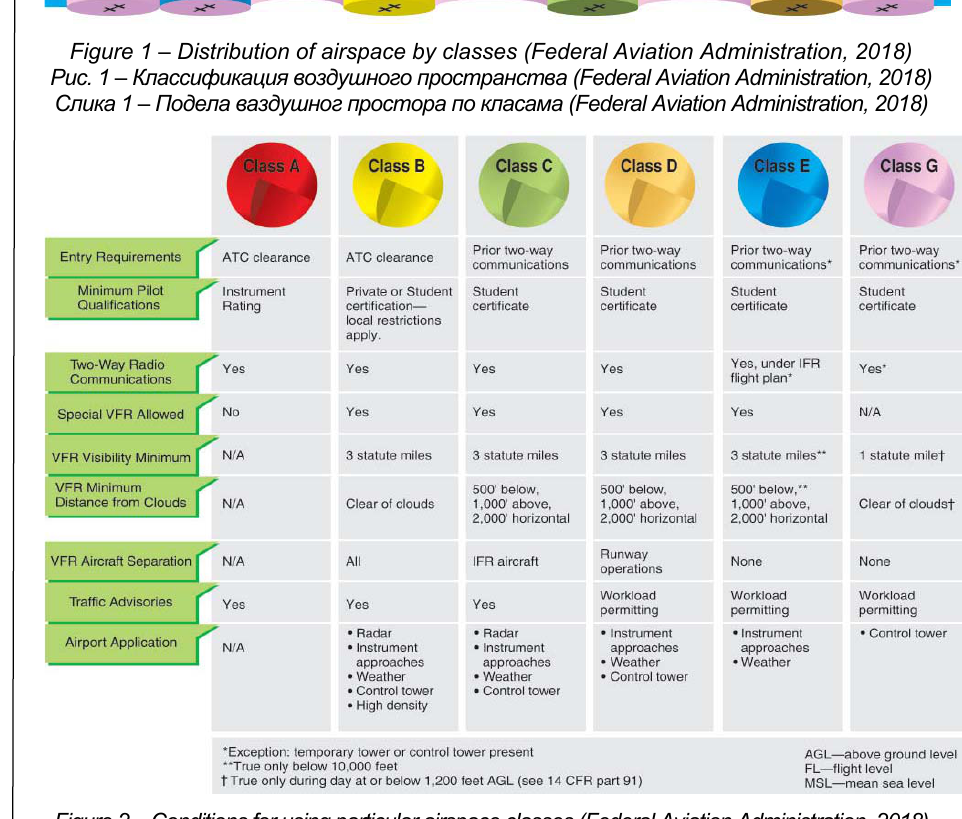
Figure 2 – Conditions for using particular airspace classes (Federal Aviation Administration, 2018) Рис . 2 – Условия использования воздушного пространства в соответствии с классом (Federal Aviation Administration, 2018) Слика 2 – Услови за коришћење одређене класе ваздушног простора